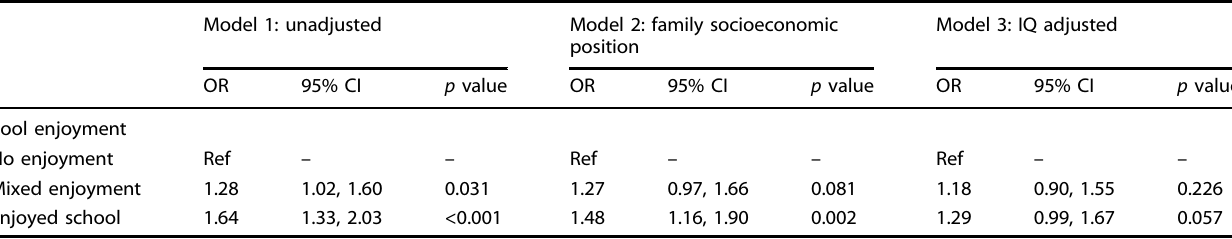
Table 4. Logistic regression of age 16 GCSE achievement (achieving 5 + A*-C grades including English and Maths) on key parameters in multiple imputation sample. Full parameter estimates provided in Supplementary Table